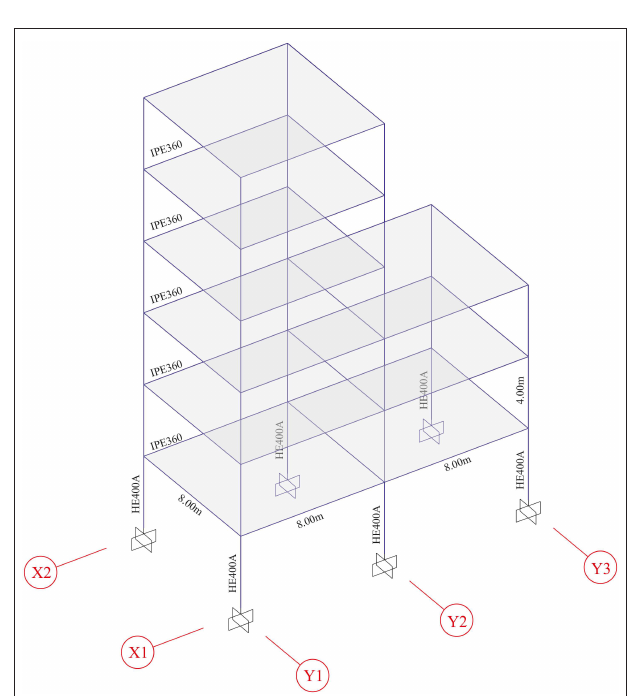
FIGURE 6 | Geometrical characteristics of the six-story three-dimensional